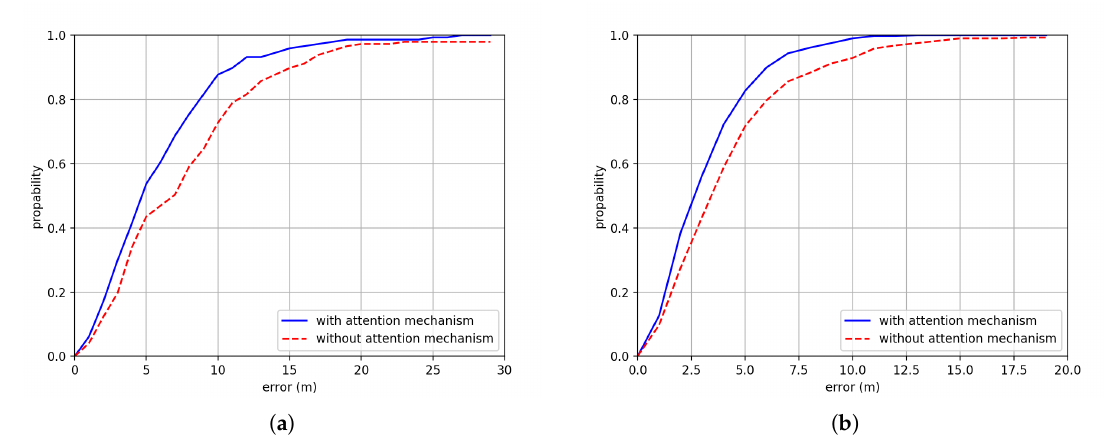
Figure 12. The CDF comparison between with attention mechanism and without attention mechanism in ( a ) Building One and ( b ) Building